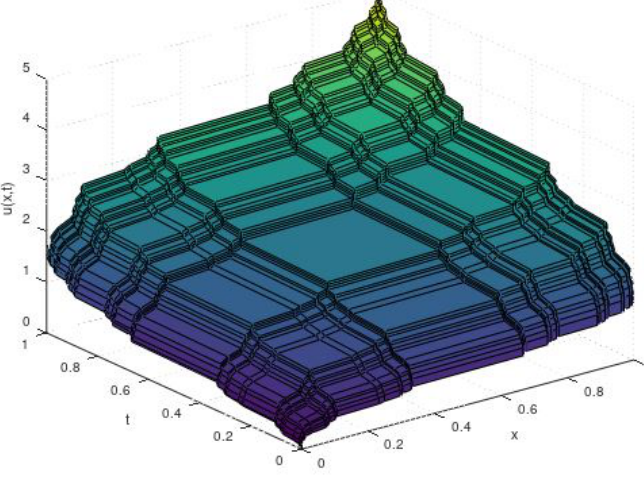
Figure 2. Outcome of Example 1 for α = 0.6309 at n = 3.